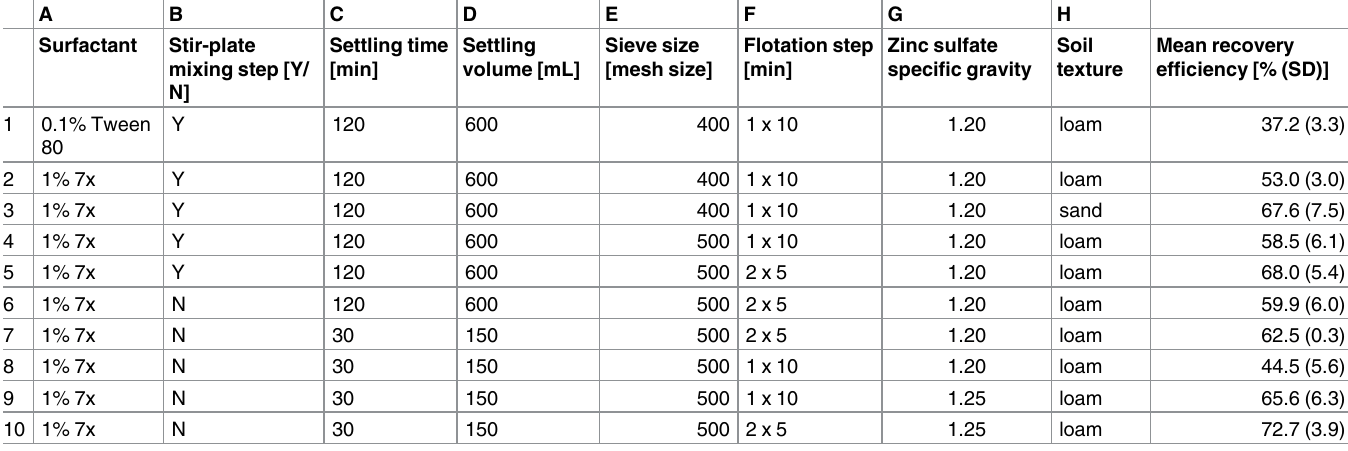
Table 1. Recoveryefficiency for methods to extract STH eggs from